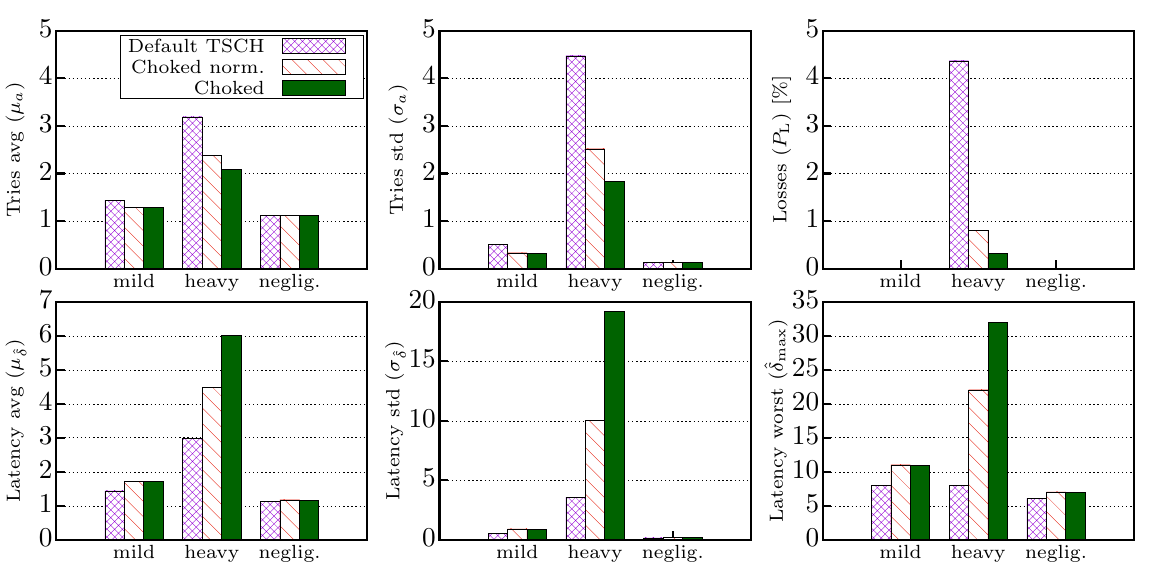
Figure 4. Performance indicators about communication for the different approaches (TSCH, ACCS, and normalized ACCS) in the three considered operating conditions (mild, heavy, and negligible